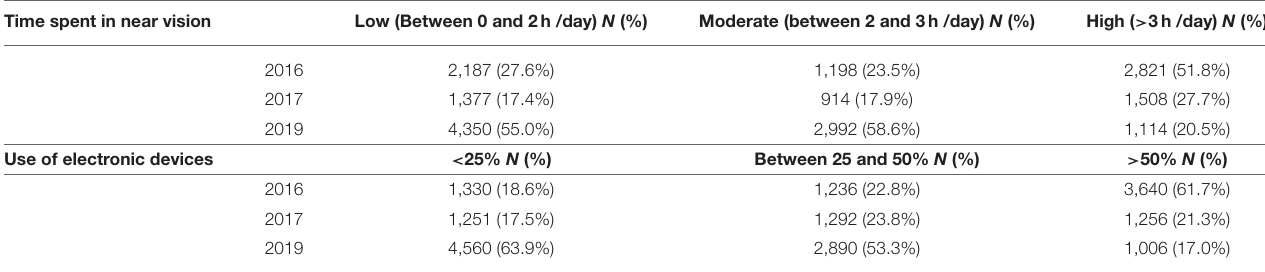
TABLE 1 | Time spent in near vision and use of digital devices by year. Time spent in near